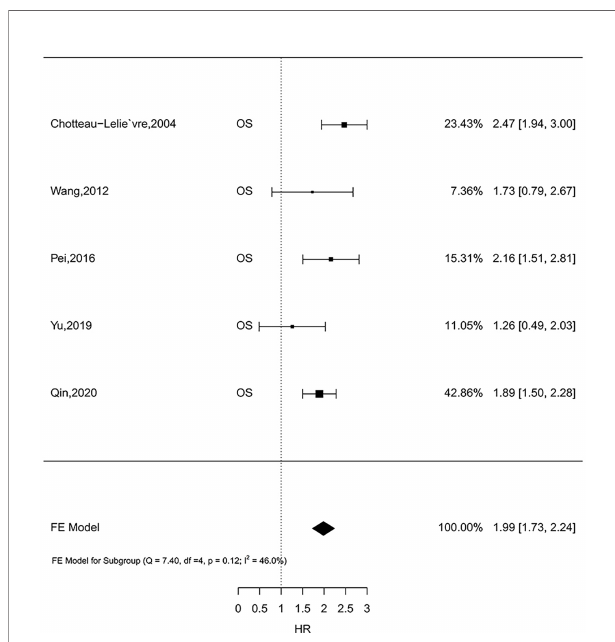
FIGURE 2 | The relationship of MSN expression and endpoints in the GEO datasets, and the results were expressed in terms of hazard ratio (HR) and 95% con fi dence interval (CI).